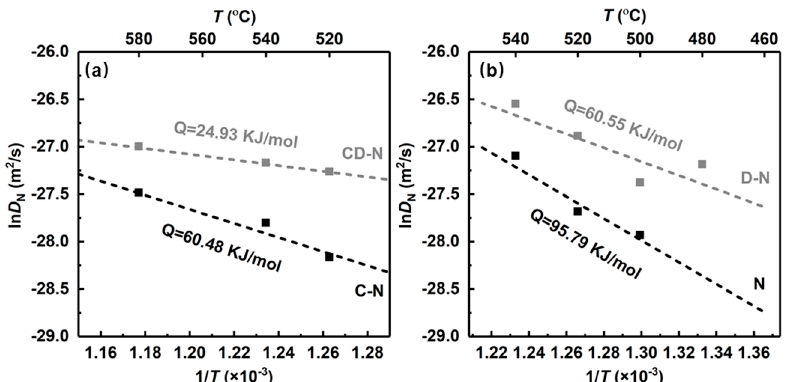
Figure 6. The activation energy for plasma nitrided samples ( a ) M50NiL C-N samples and CD-N samples, ( b ) M50 N samples and D-N samples.